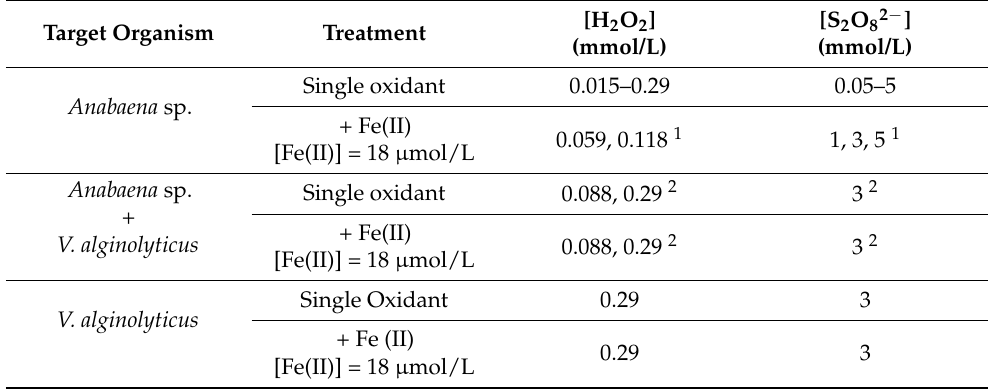
Table 1. Experimental approach for assessing H 2 O 2 - or S 2 O 82 − -based processes on Anabaena sp. and V. alginolyticus in a